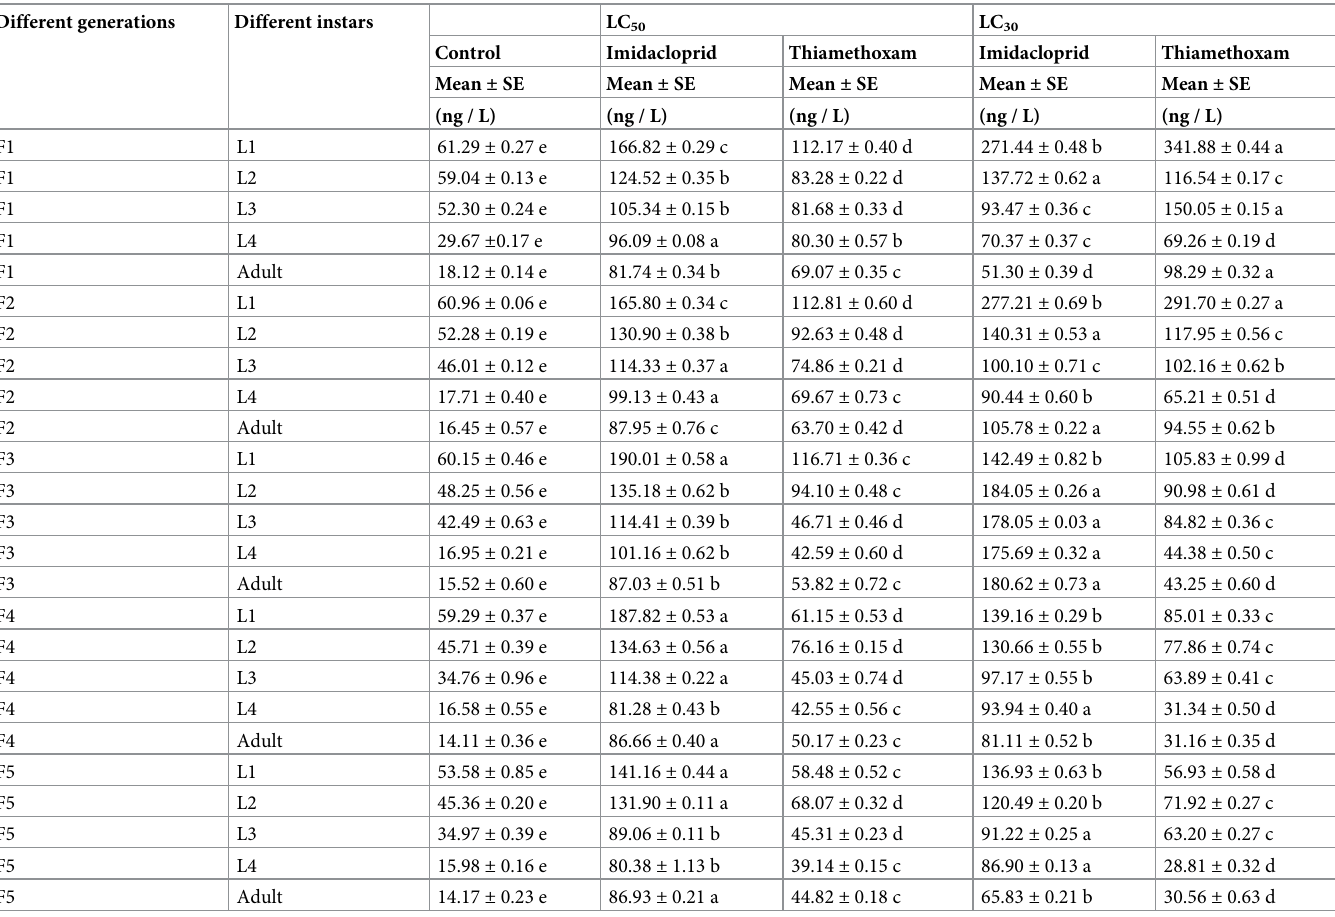
Table 2. Effects of imidacloprid and thiamethoxam on the expression of juvenile hormone of soybean aphids in each generation. Different